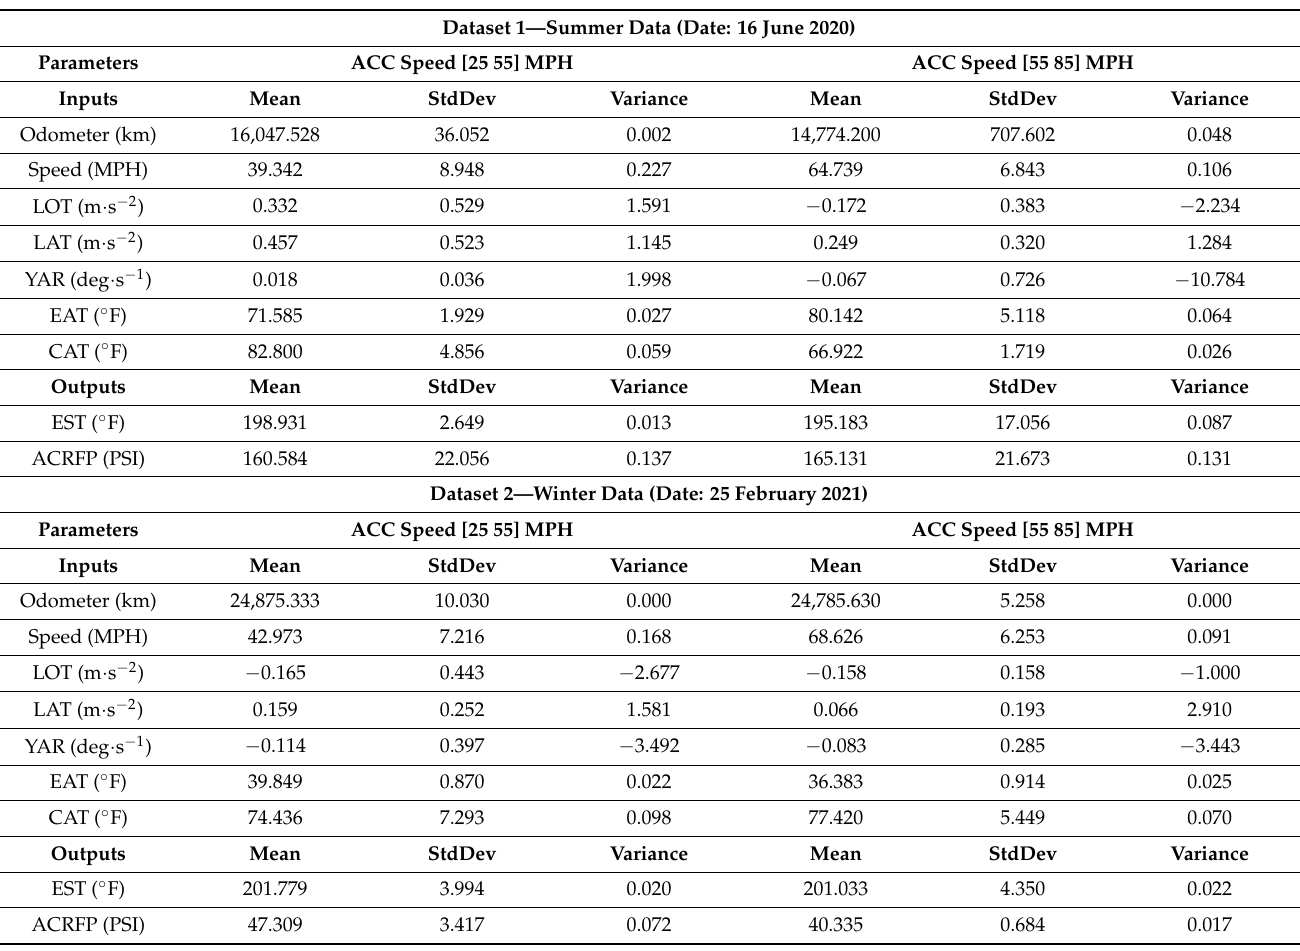
Figure 5. Path traversed—2020 Cadillac CT5 [Source: Google maps]. Table 6. Dataset sets—Real-time testing: 2020 Cadillac